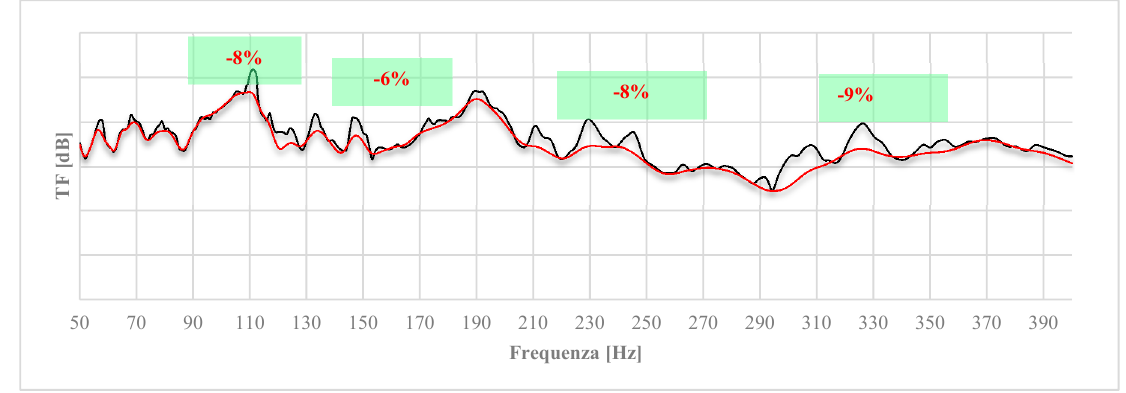
Figure 30. Vibroacoustic transfer functions (TF) from the shock absorber attachment to the ear node (MIC 2)—contribution of all panels, for pavilion made of TCA (black line) and PP23CF OPTIMIZED (red line).